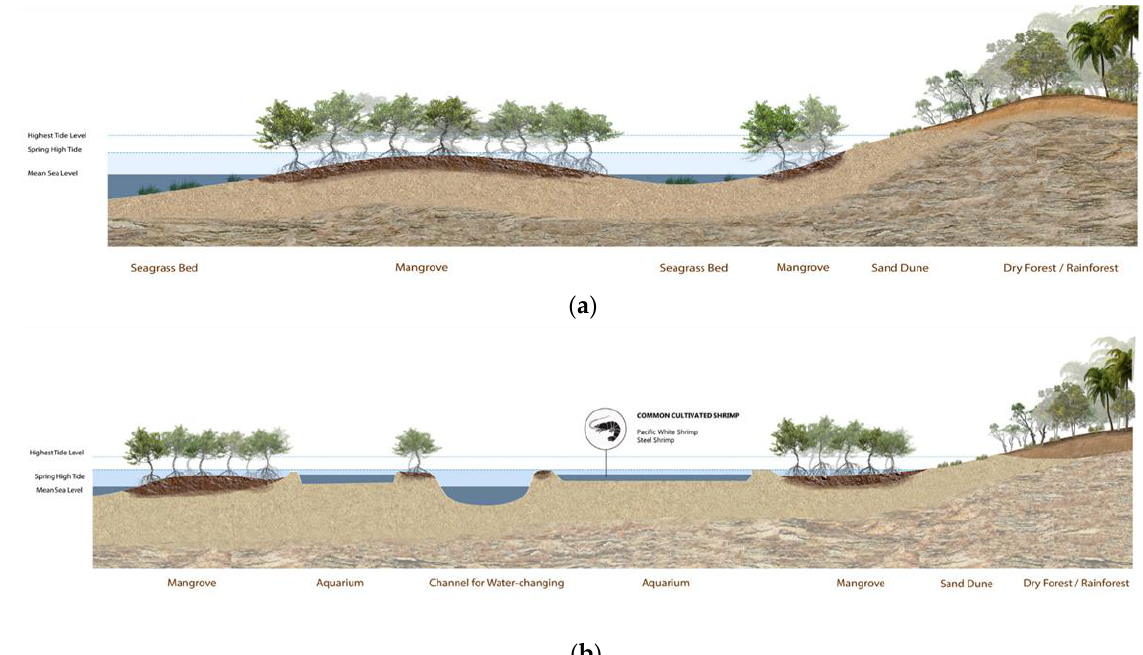
Figure A2. ( a ) A healthy mangrove ecosystem. ( b ) A deforested mangrove ecosystem that suffers from contaminated water, soil erosion, and fragmented mangrove systems can further die-off. © Shuwen Ye and Aubrey Jahelka.